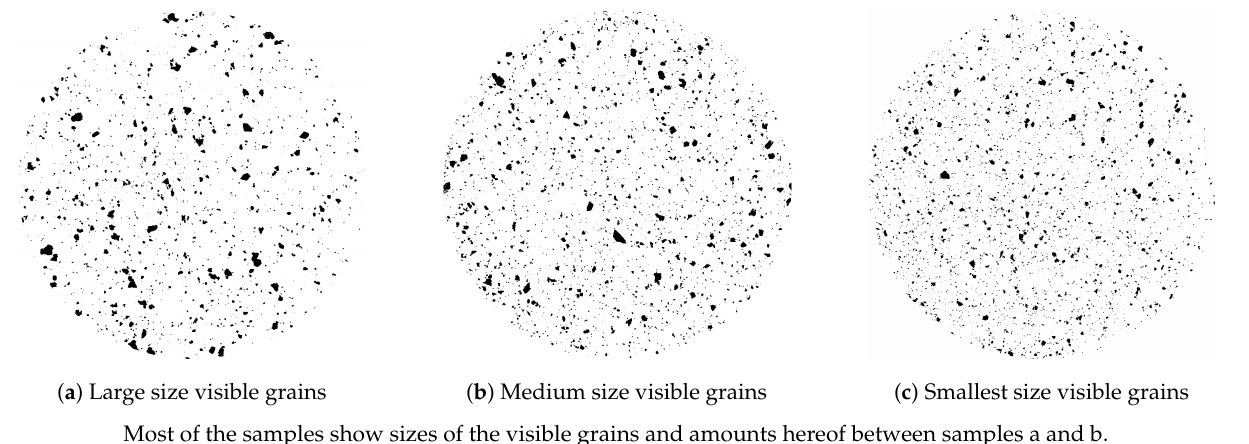
Figure 9. White Rubber Analysis of de-vulcanizates differing in particle size distribution; the diameter of the samples is